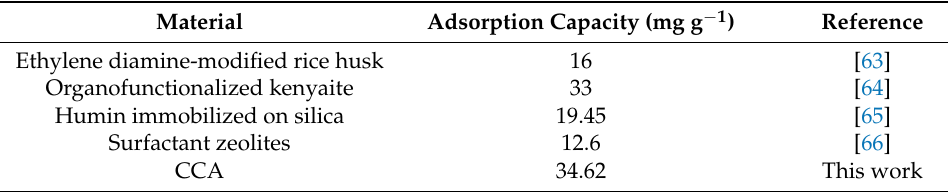
Table 4. Comparison with the reported Table 3. Sustainability parameters.